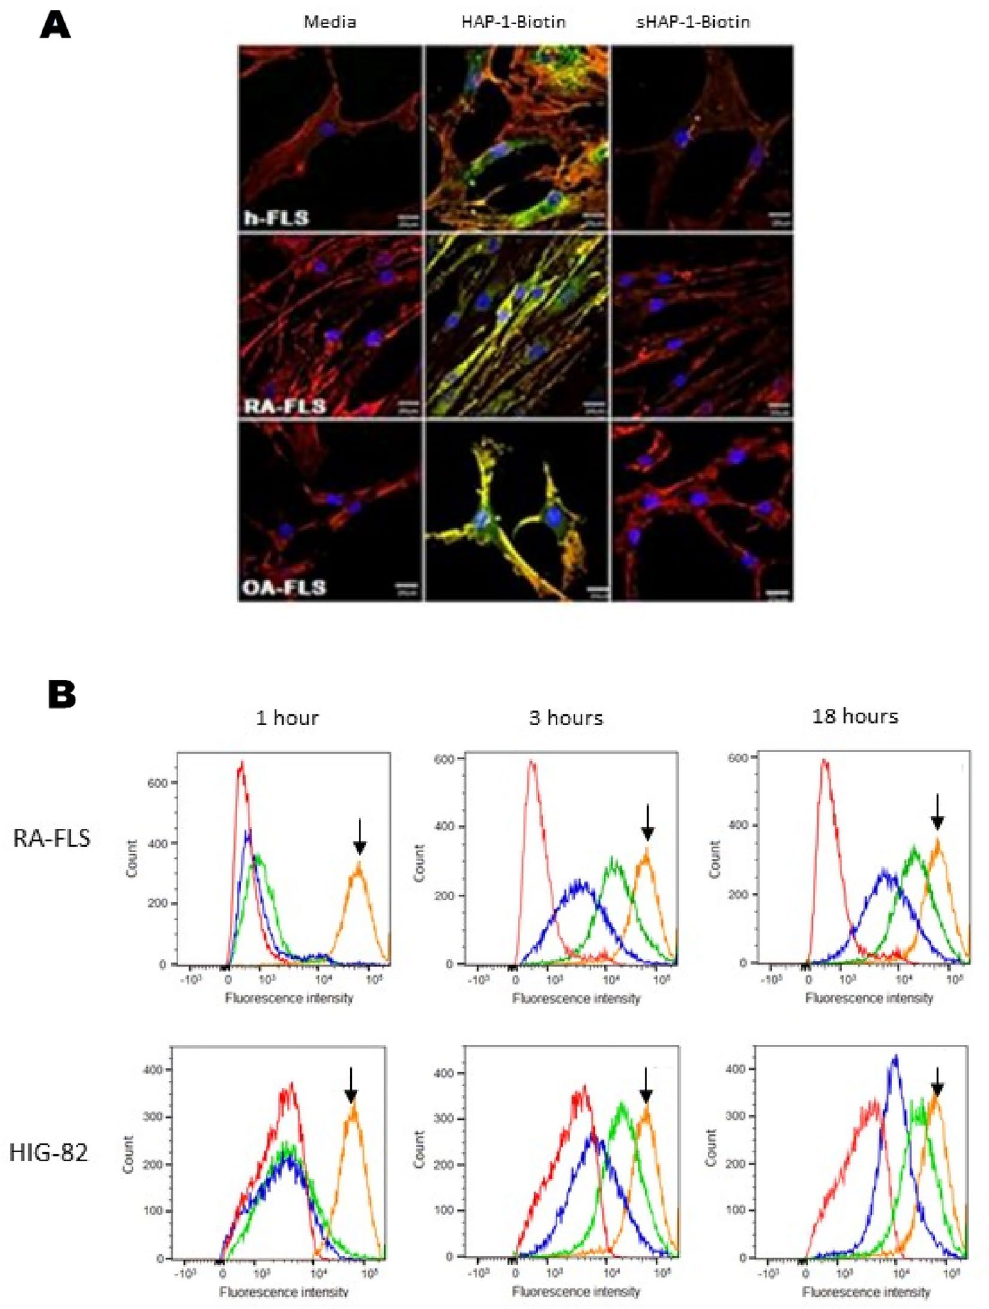
Figure 2. ( A ) Confocal microscopy of HAP-1-binding to human (h)-FLS, RA-FLS and OA-FLS cells. Cells at 37 ̊ C were incubated with media, HAP-1-biotin, or sHAP-1-biotin followed by streptavidin-FITC. Actin is labelled with TRITC-phalloidin (red), HAP-1-biotin with streptavidin-FITC (green), and nuclei with DAPI (blue). Scale bars represent 100 μm. Positive binding was present for HAP-1-biotin treated HIG-82 and all h-FLS cell types. The bin ding pattern of HAP-1-biotin appeared to be consistent across the RA and OA h-FLS cell types with positive staining present on both the surface (yellow) and cytoplasmic internalization (green). Cells incubated with either media or sHAP-1-biotin showed no green FITC-stain demonstrating the binding specificity of the HAP-1 sequence. ( B ) Flow cytometry histograms illustrating uptake of NP non-targeted and NP HAP-1 following incubation for 1, 3 and 18 h at 37 °C with RA-FLS or HIG-82 cells. Autofluorescence is shown as red, incubation with NP non-targeted as blue, incubation with NP HAP-1 green, and incubation with free DiD dye (orange, shown as arrow). The experiments were repeated three times and the histogram is the